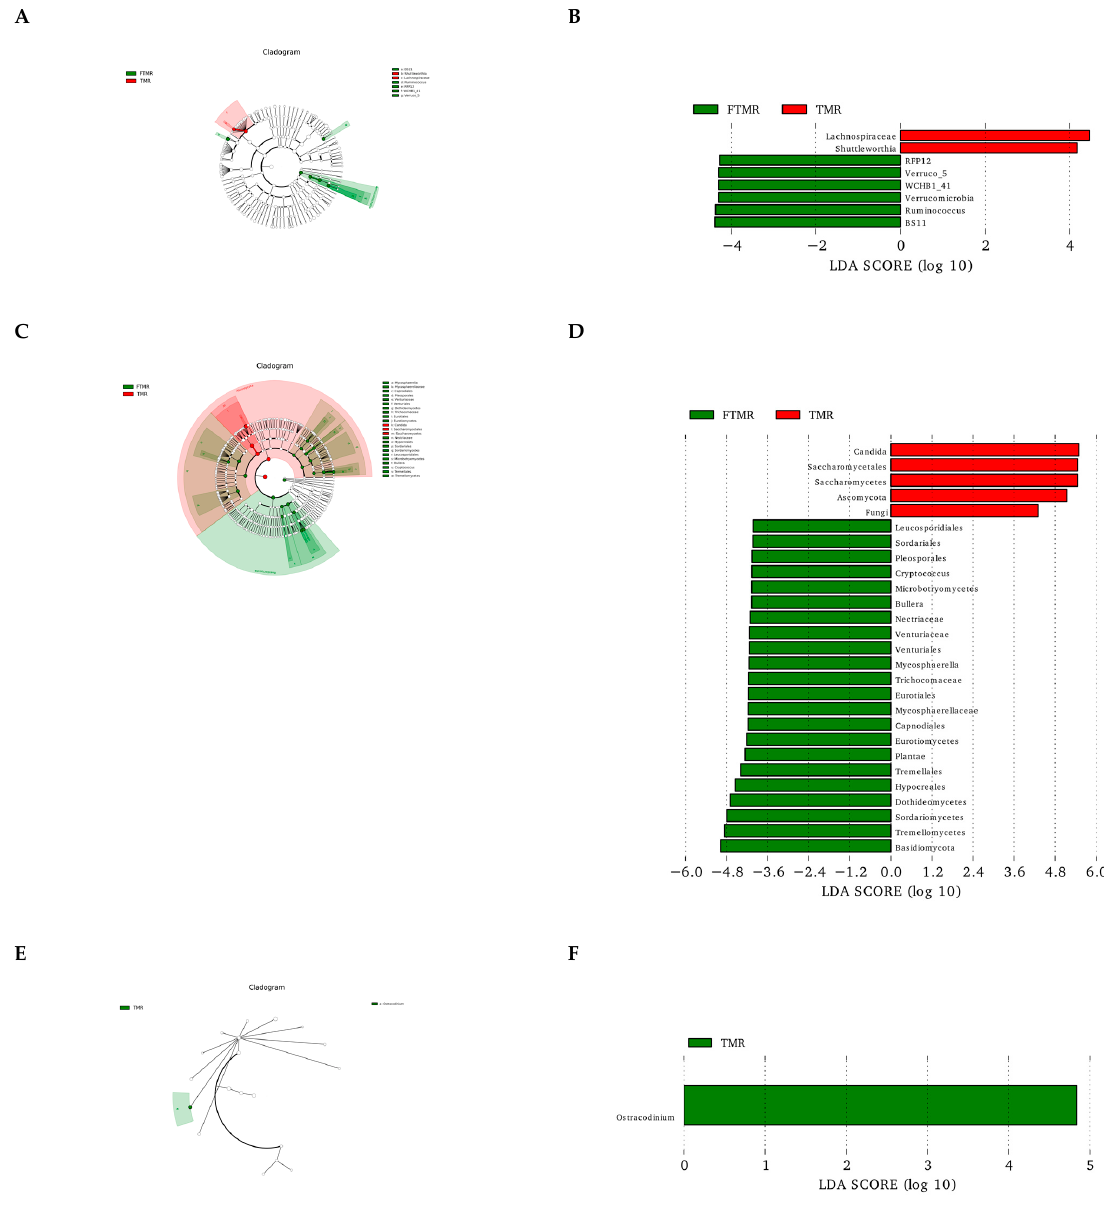
Figure 6. The LDA effect size (LefSe) analysis. The cladogram diagram shows the microbial genera with significant differences in the TMR and FTMR groups (from phylum to genus level). The clado- gram diagram of bacteria ( A ), anaerobic fungi ( C ), protozoa ( E ); species with significant differences that have a linear discriminant analysis (LDA) score greater than the estimated value ( B , D , F ). The histogram of bacteria ( B ), anaerobic fungi ( D ), and protozoa ( F ). Significant differences are defined as p < 0.05 and LDA score > 4.0. The histogram length represents the LDA score, i.e., the degree of influence of the species with the significant differences between the different groups. TMR, total mixed ration; FTMR, fermentation total mixed